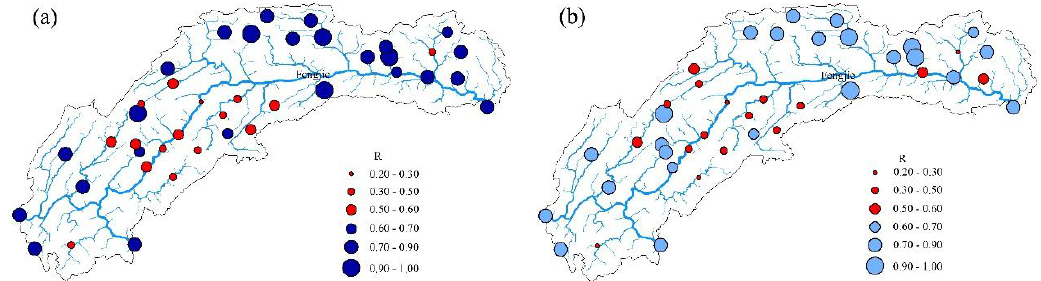
Figure 3. Time series correlation coefficient (( a ) annual precipitation; ( b ) flood season precipitation). The multi-year average annual precipitation of 41 sites is 1110.54 mm, and the corresponding TRMM multi-year average annual precipitation is 1270.54 mm, the overall value being 14.40% higher than the measured value. The multi-year average annual precipitation of 41 sites is 851.88 mm in the flood season, and the corresponding TRMM multi-year average annual precipitation is 963.60 mm, the overall value being 13.11% higher than the measured value. The relative error ( RE ) of each site is shown in Figure 4.